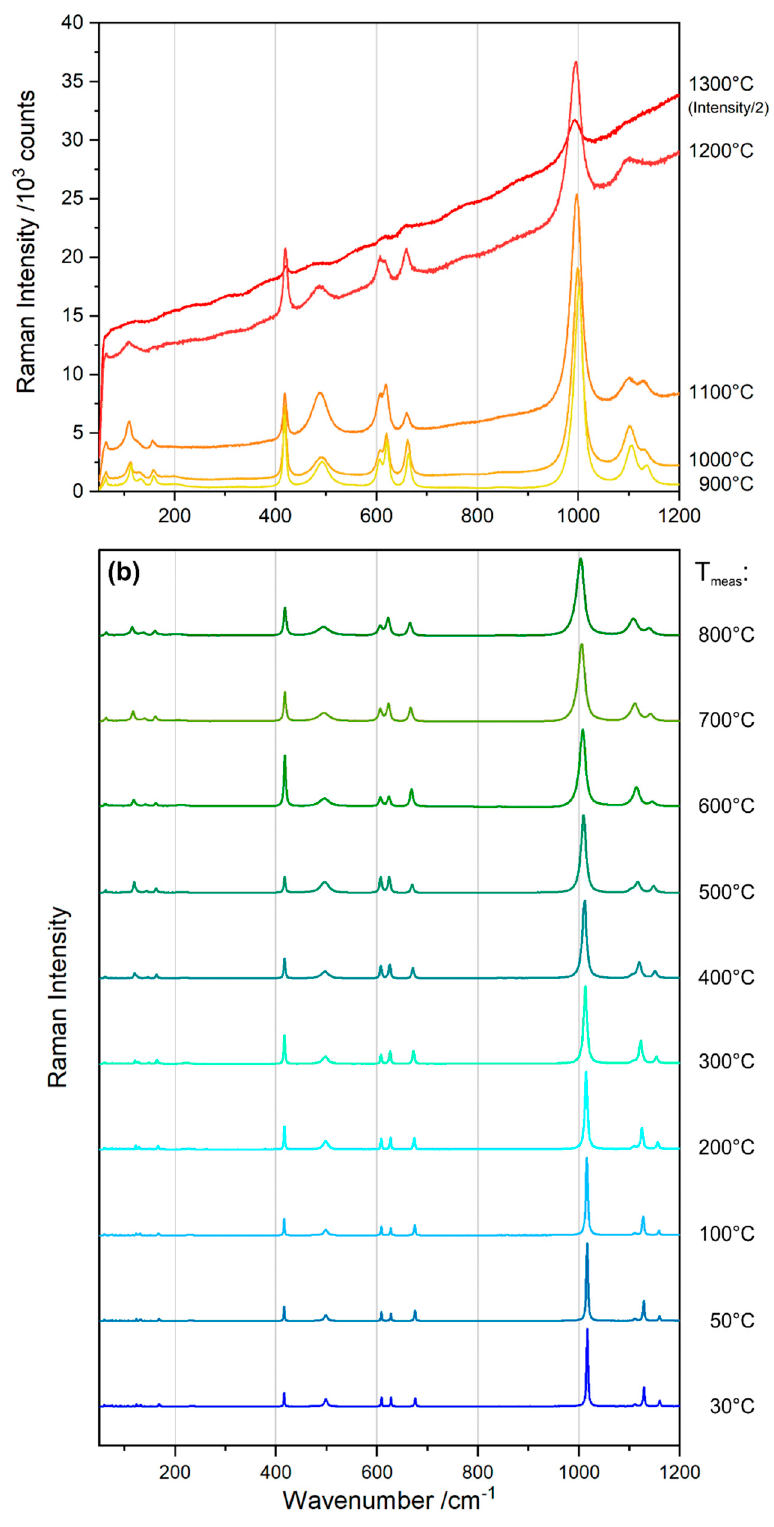
Figure 3. Raman spectra of anhydrite II (T burn = 1200 °C) acquired in situ at different measurement temperatures (T meas ). Spectra in ( a ) are shown as measured (the intensity of the 1300 °C spectrum was reduced by a factor of 0.5), and spectra in ( b ) were normalised and stacked by adding offset values.